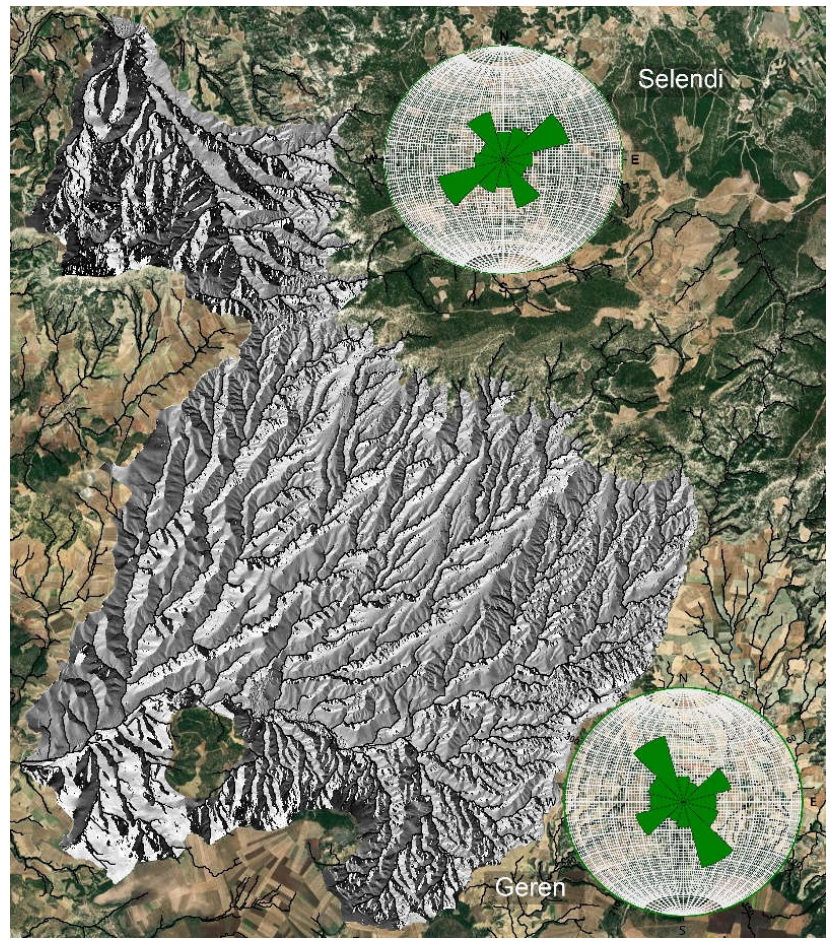
Figure 6. Shaded relief and slope orientations plotted on rose diagrams for Selendi ( upper left ) and Geren ( lower right ) catchments.